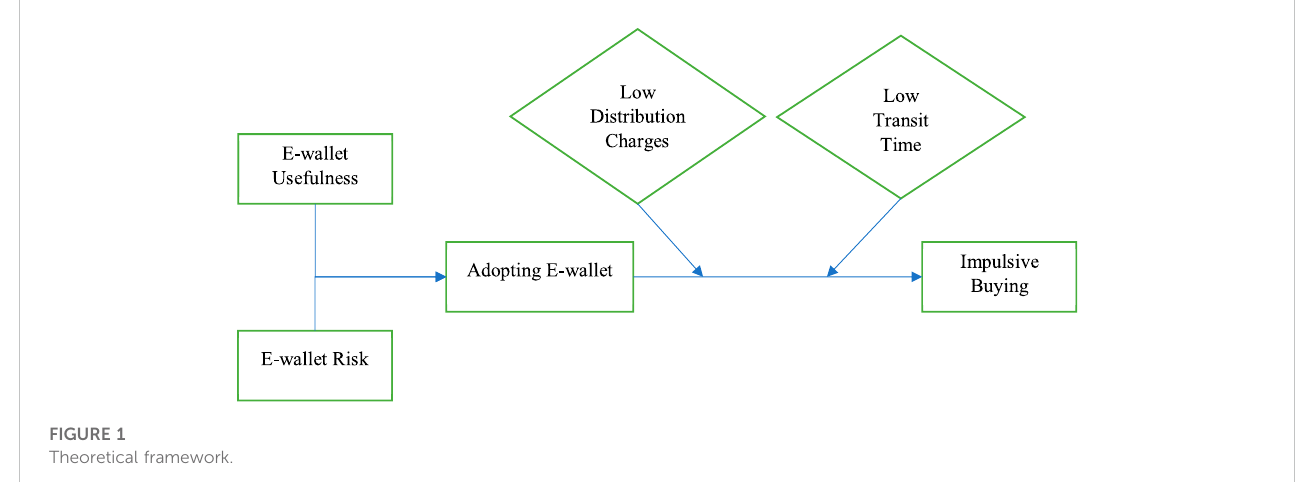
FIGURE 1 Theoretical framework.